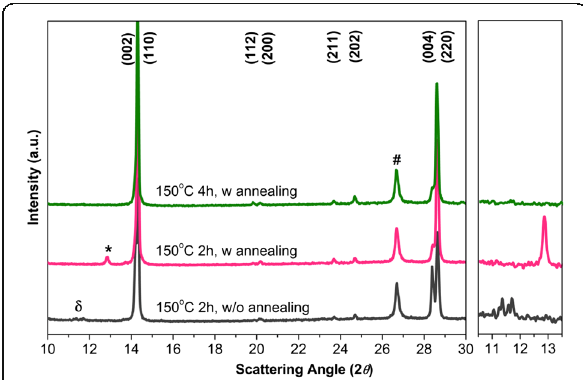
Fig. 2 XRD data of the perovskite thin films, according to MAI processing time and post-annealing execution. The perovskite plane indices are assigned, and the peaks for the perovskite complex, PbI 2 , and FTO are also denoted as δ , *, and #,